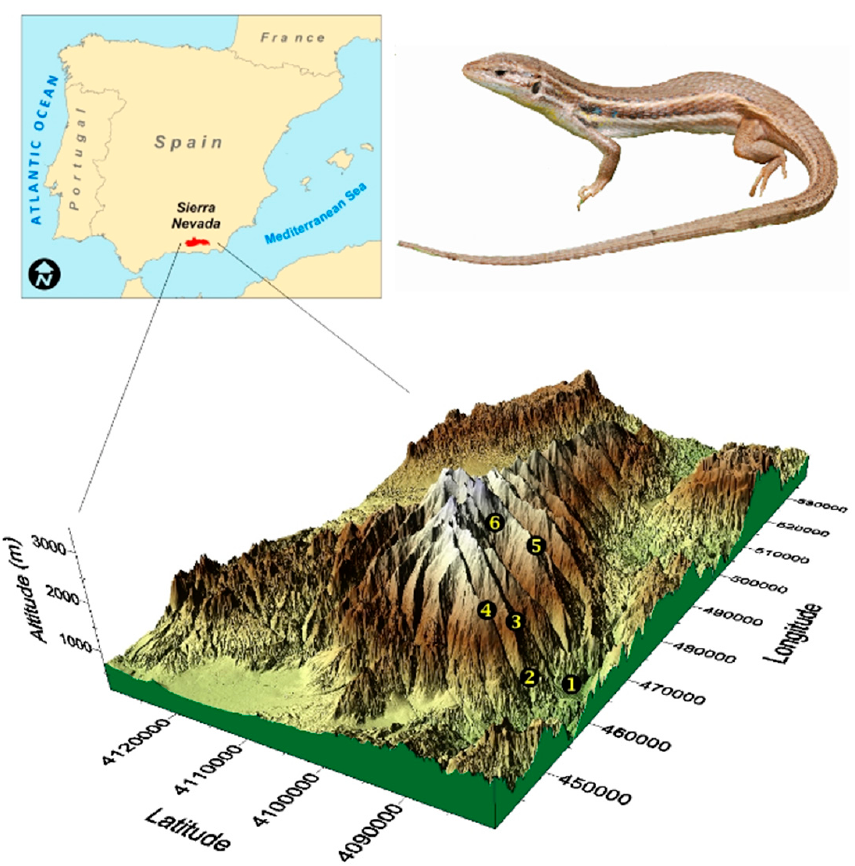
Figure 1. The three-dimensional map (bottom panel) is a representation of the Sierra Nevada Mountain and displays the location of the six sites sampled during this study along the elevational gradient: 300 (1), 700 (2), 1200 (3), 1700 (4), 2200 (5), and 2500 (6) m asl. The location of Sierra Nevada in the Iberian Peninsula ( top , left ) and an image of the lizard ( top , right ) are also shown.